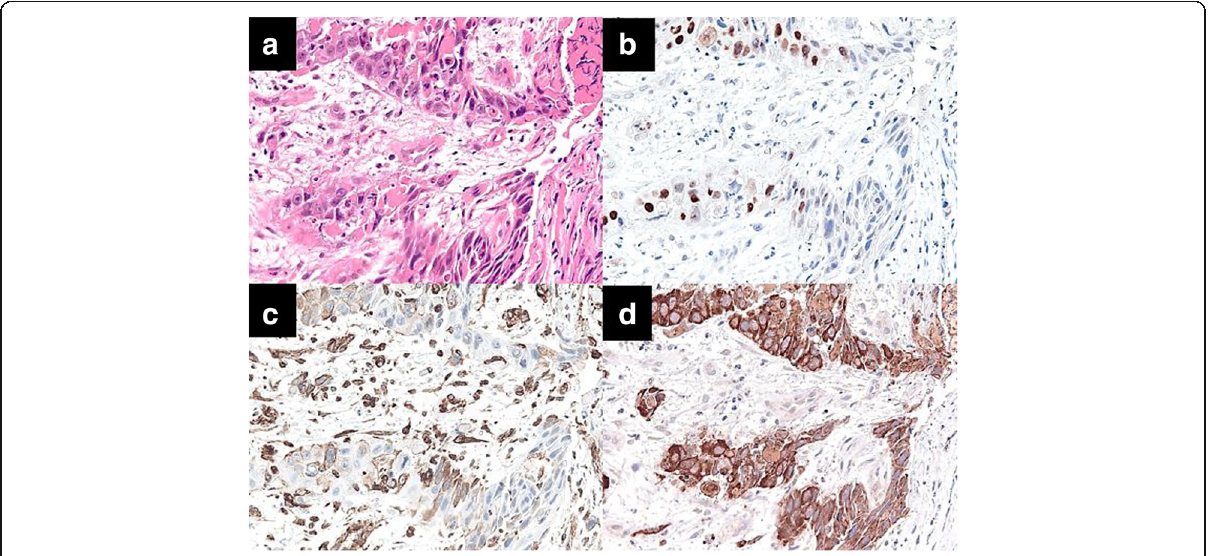
Fig. 3 Microscopic and immunohistochemical findings of a biopsy specimen from the transitional zone between the carcinomatous and sarcomatous components. a – d In the transitional zone between the two components, there were scattered malignant cells expressing pan-cytokeratin, vimentin, or p63. a Hematoxylin and eosin, b p63, c vimentin, and d pan-cytokeratin